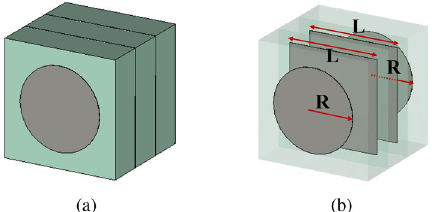
Figure 2. Phase-transforming cell configuration. ( a ) Perspective view. ( b ) Internal configuration of PTC, showing metal patches on four layers.